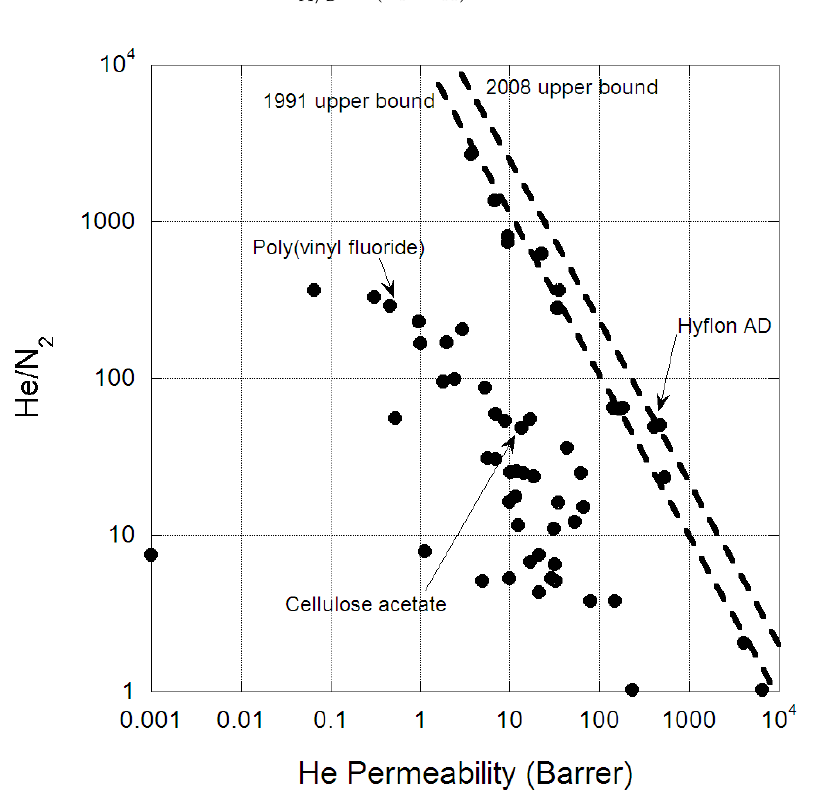
Figure 1. Permeability (Barrer) versus selectivity for polymeric membranes separating helium from nitrogen.